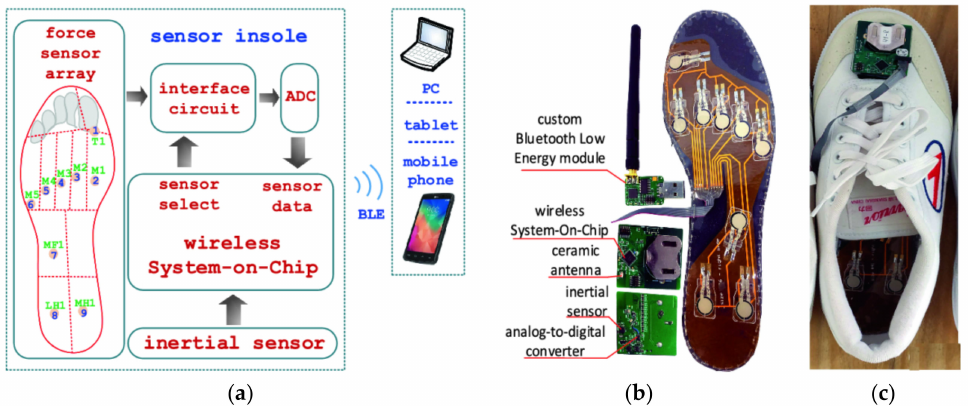
Figure 2. Smart insole proposed in [35], Copyright Clearance Center_Springer Nature_Copyright Permission_Figures 2 and 3.pdf: block diagram of the proposed solution ( a ); view of the prototype with highlighted main sections ( b ); insole installed in a shoe ( c ).